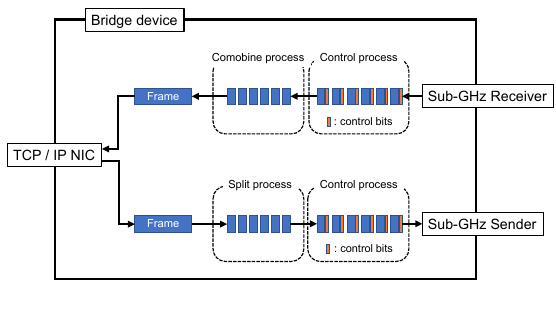
Figure 3. Traffic flow in the communication